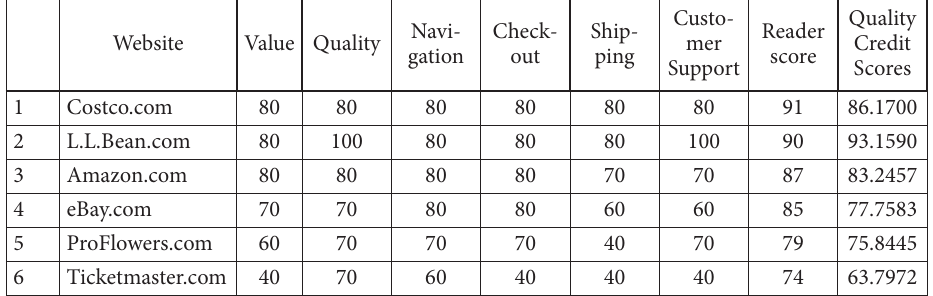
Navi- Check- gation